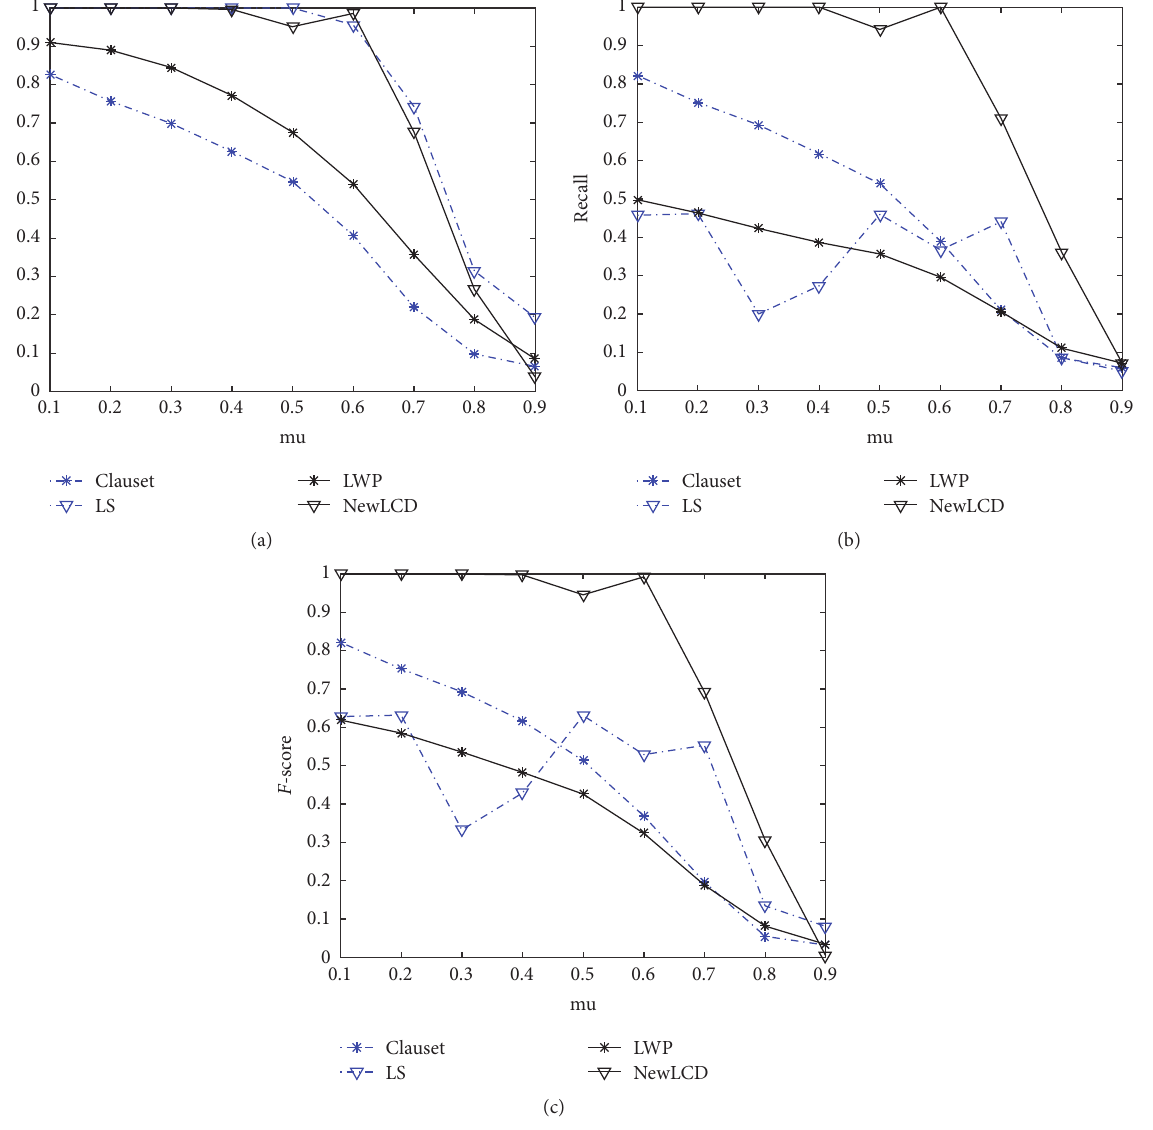
Figure 5: Comparison of